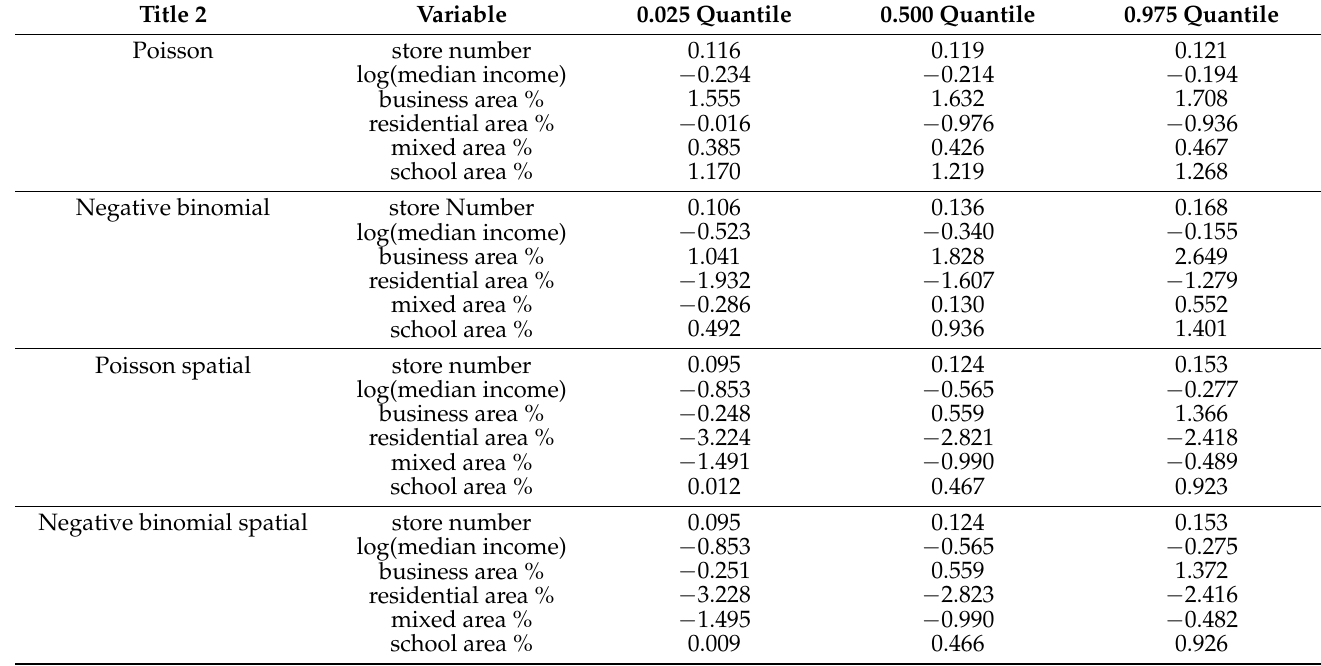
Table 3. The 95% credible intervals of the posterior mean of the independent variables by four Bayesian hierarchical